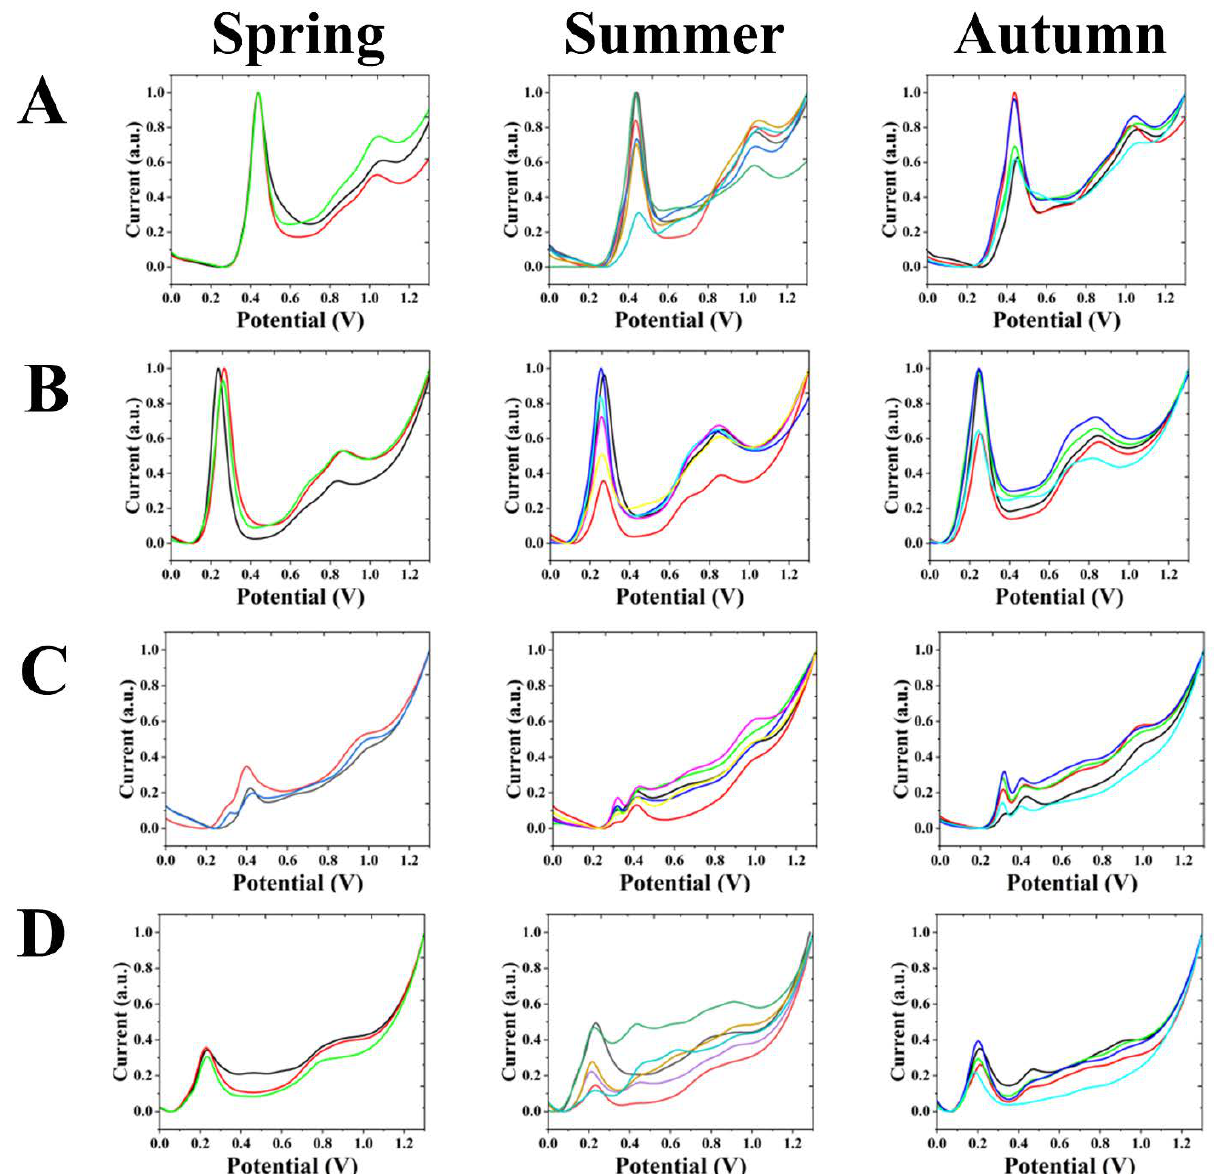
Figure 3. Electrochemical fingerprints of A. palmatum ‘Matsumurae’ in different seasons under ( A ) water-ABS, ( B ) water-PBS, ( C ) ethanol-ABS and ( D ) ethanol-PBS conditions.